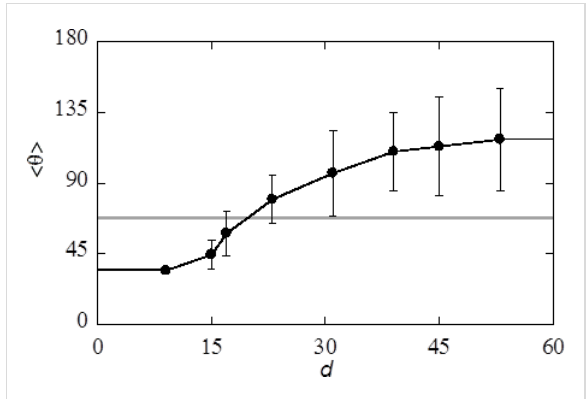
Figure 11: Advancing averaged contact angle and standard devia- tion as a function of the cavity diameter d (in lattice units) for a hexago- nally ordered inverse opal with cut-off fraction c = 0.8, distance be- tween cavities s = d − 1 and slightly hydrophilic surface properties χ S = − 0.3. The grey line is contact angle θ Y on a smooth surface.